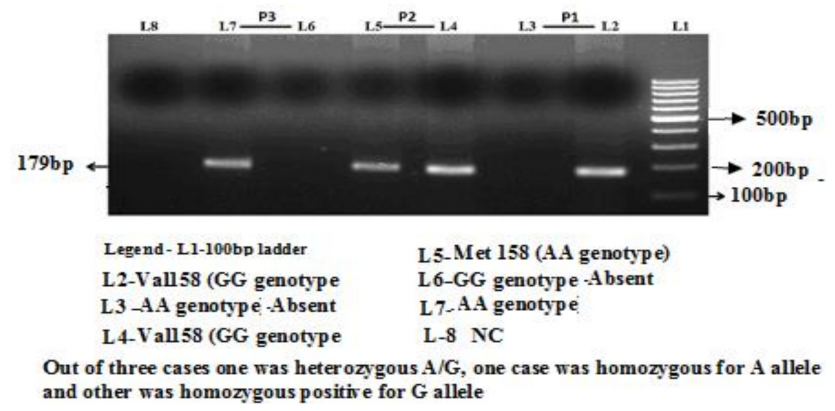
Figure 1. Allele-specific polymerase chain reaction (PCR) for the detection of catechol- O - methyltransferase (COMT) (Vall58Met) G > A gene polymorphism.